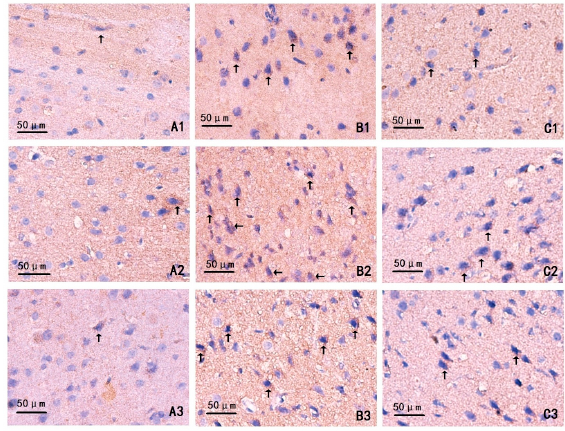
Figure 3. The expression of phospho-c-Jun NH 2 -terminal kinase (pJNK) in cortex of rats shown by immunohistochemical assay, magnification 400×, scale bar = 50 µm. ( A1 – A3 ) Sham-operated groups (24 h subgroup, 72 h subgroup, and 120 h subgroup); ( B1 – B3 ) ICH groups (24 h subgroup, 72 h subgroup, 120 h subgroup); and ( C1 – C3 ) MIHA groups (24 h subgroup, 72 h subgroup, 120 h subgroup); (arrows) positive cells.